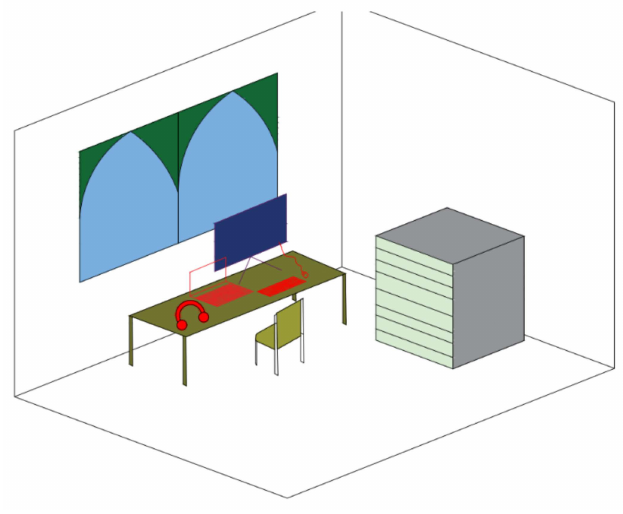
Figure 3. Therapist’s private workspace and data server